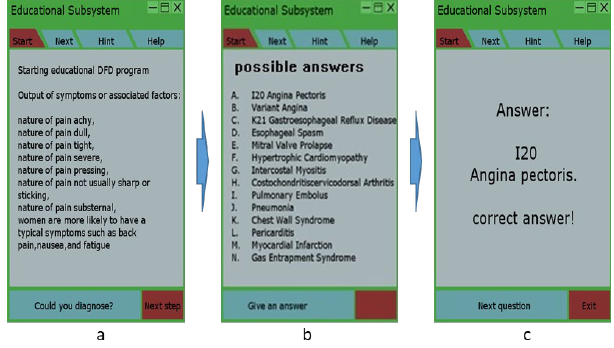
Figure 2. Selecting symptoms for Chest Pain (a), selecting diagnosis for Chest Pain (b), and checking the given answer for Chest Pain